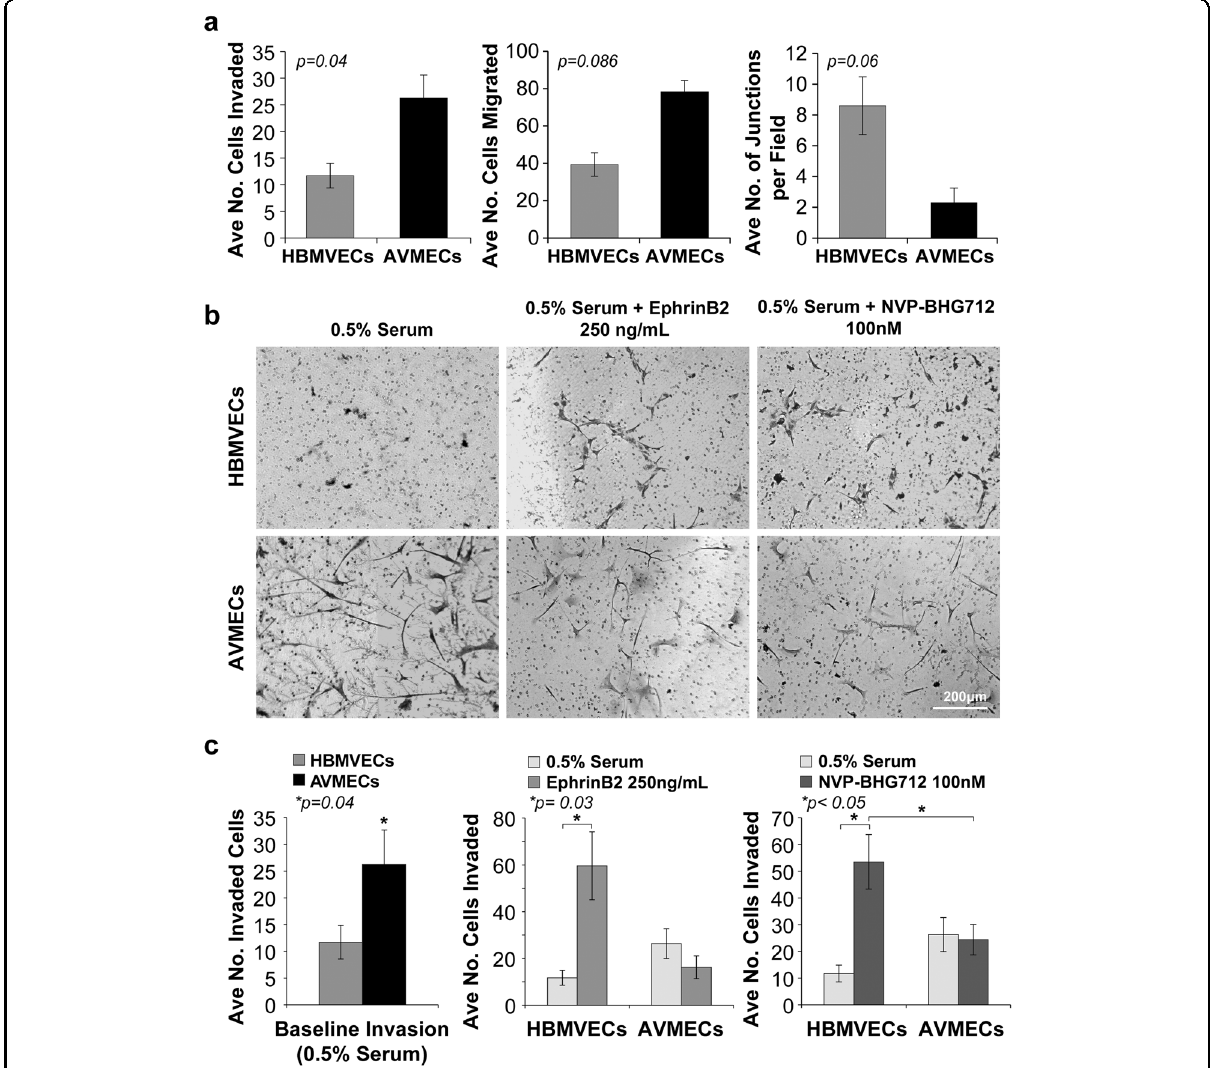
rates of invasion ( p = 0.04) and migration ( p = 0.086) and decreased tube formation ( p = 0.06). Perturbations to the EphrinB2/EphB4 ratio (either increasing EphrinB2 or decreasing EphB4) can alter the phenotype of normal HBMVECs to mimic an exaggerated AVM response. a , b At baseline (0.5% serum), AVMEC invasion was at a rate that was nearly double that of HBMVECs ( p = 0.04). b , c Stimulation with 250 ng/mL exogenous EphrinB2 increased HBMVEC invasion (* p = 0.03). b , c Inhibition of EphB4 with 100 nM NVP BHG increased HBMVEC invasion (* p <